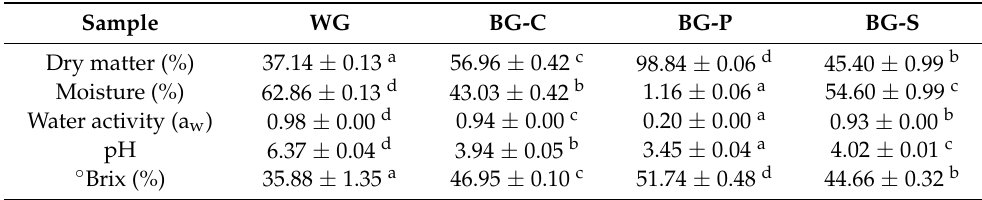
Table 1. Physicochemical characterization of white garlic and black garlic